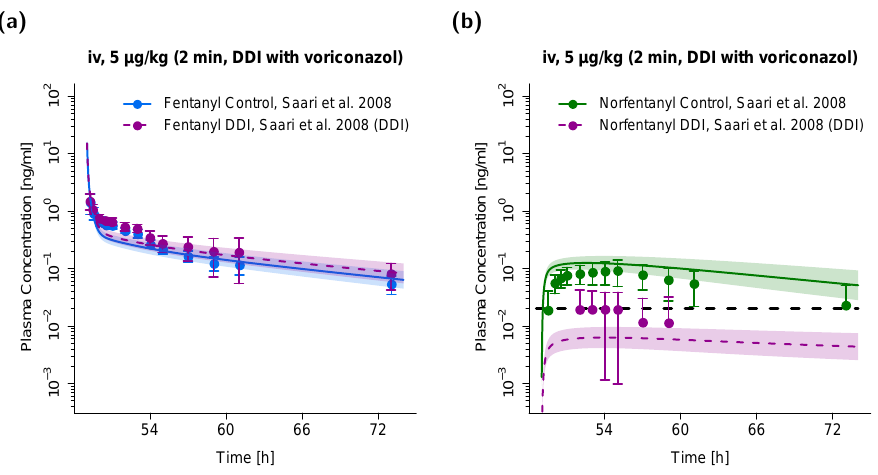
Figure 4. DDI scenario for fentanyl ( a ) and norfentanyl ( b ) with the perpetrator drug voriconazole in adults. Fentanyl and norfentanyl plasma concentrations during concomitant administration of voriconazole are shown in purple. Plasma concentrations during sole fentanyl administration are shown in blue (fentanyl) and green (norfentanyl), respectively. Population simulations ( n = 100) are shown as lines with shaded areas (geometric mean and geometric standard deviation). Observed data is shown as filled circles ± standard deviation. References link to a specific observed dataset described in Table 1. Black dashed line depicts the specified lower limit of quantification (LLOQ) for norfentanyl [6]. Predicted and observed areas under the plasma concentration–time curve from the first to the last data point (AUC last ) are compared in Table S5 of the Supplementary Materials. DDI, drug–drug interaction; iv,